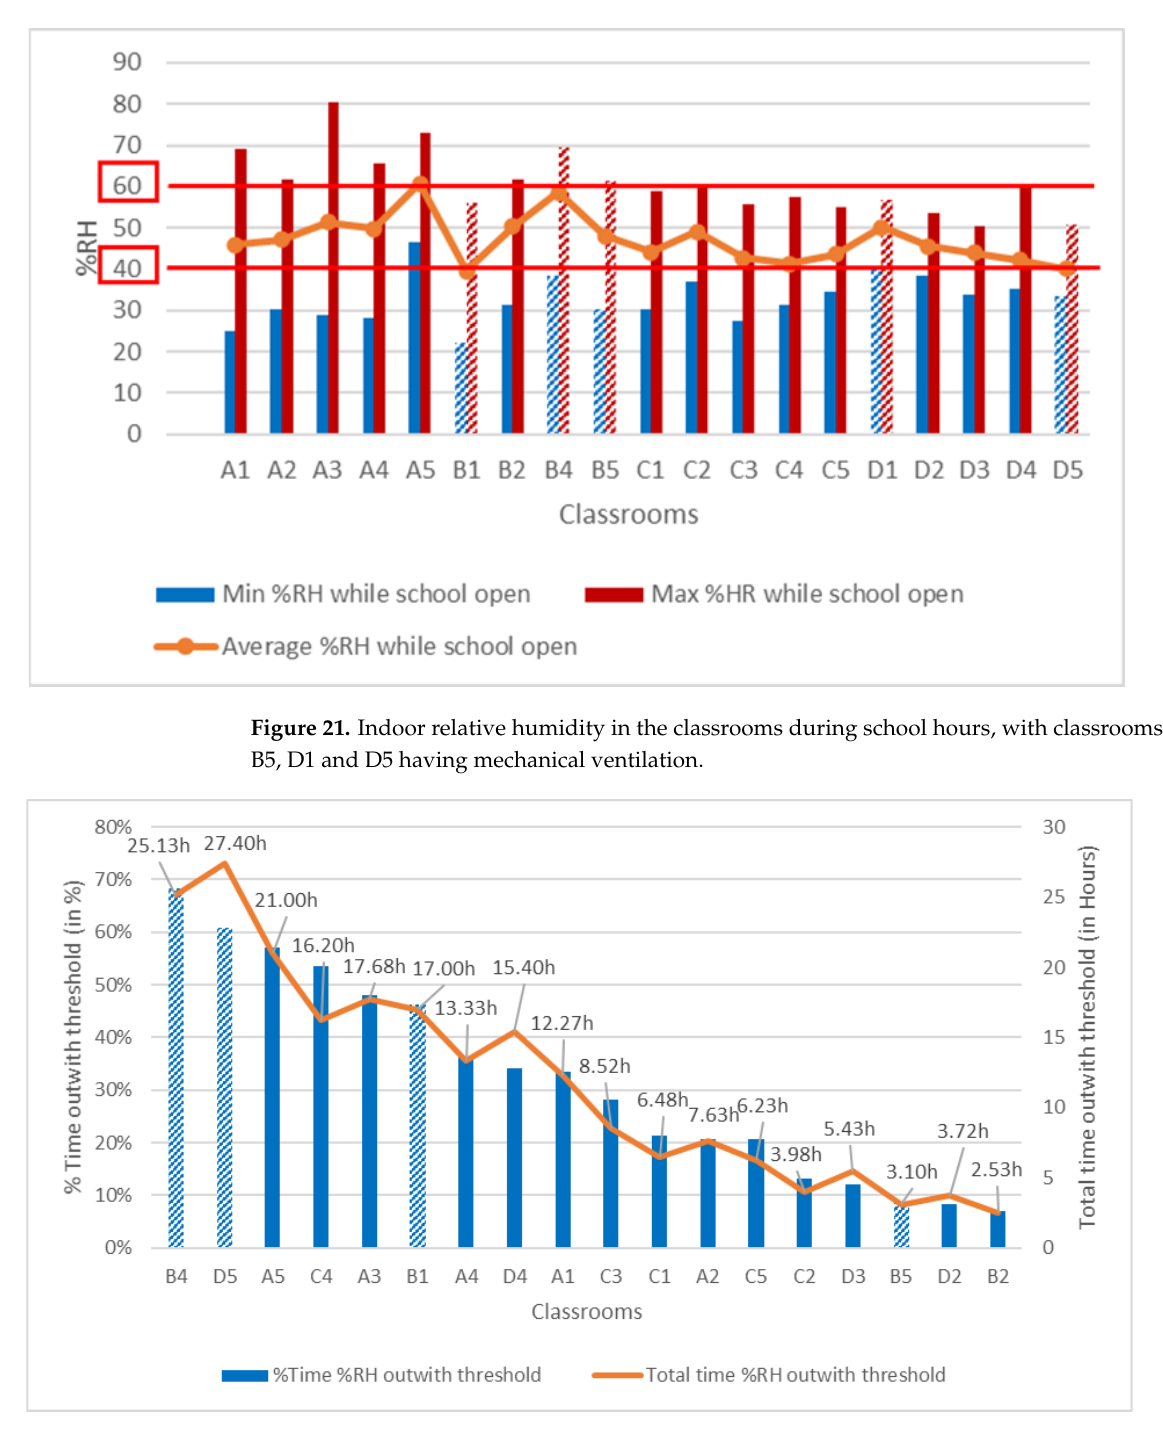
Figure 22. Total time when RH out with threshold (in % and in hours), with classrooms B1, B4, B5, D1 and D5 having mechanical ventilation.